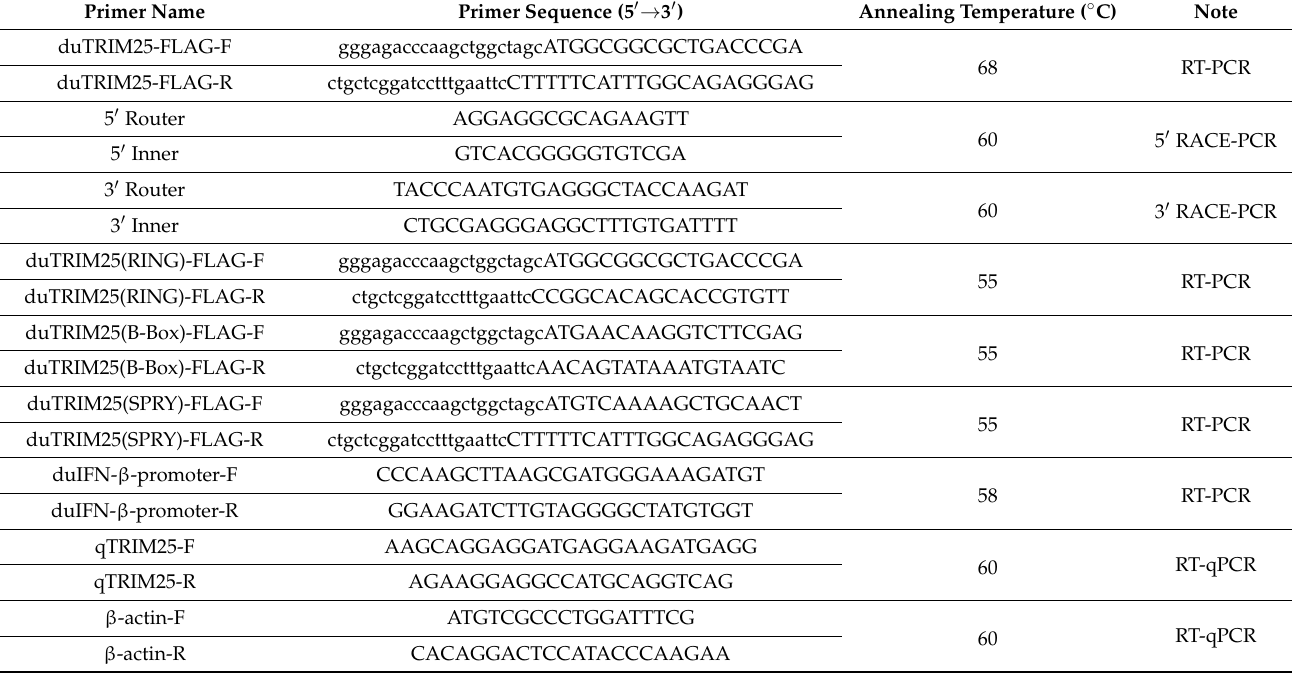
Table 1. Primers used in the